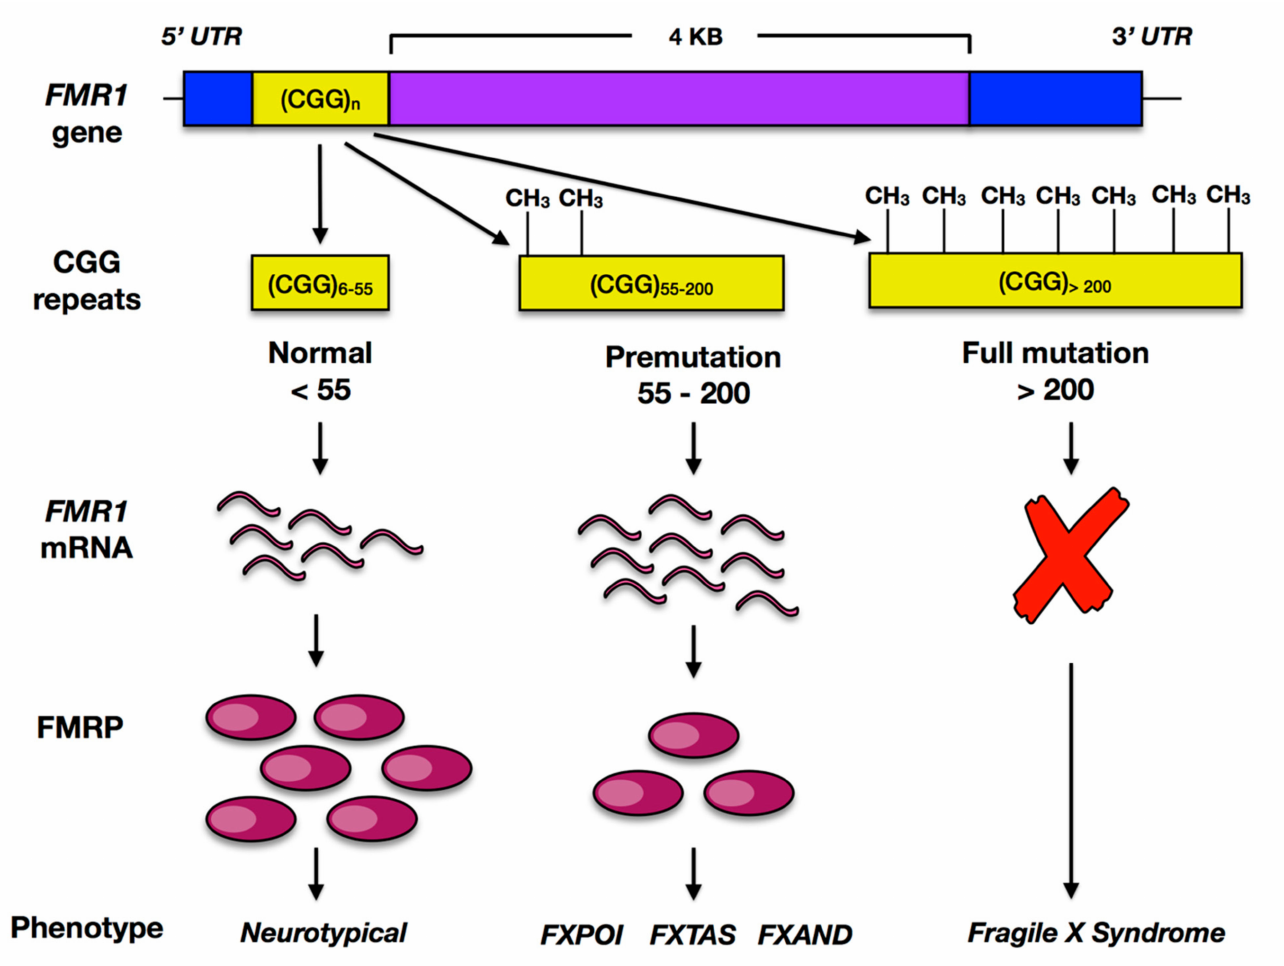
Figure 1. The FMR1 gene and Fragile X pathology. CGG repeats (yellow) in the promoter region. <55 repeats are typical. Repeat expansion resulting in the premutation (55–200) is found in 1/130–250 females and 1/260–800 males. The premutation expansion increases mRNA transcription and is associated with Fragile X primary ovarian insufficiency (FXPOI), Fragile X-associated tremor and ataxia syndrome (FXTAS), and Fragile X-associated neuropsychiatric disorder (FXAND). Repeats greater than 200 results in the methylation of the promoter region and gene